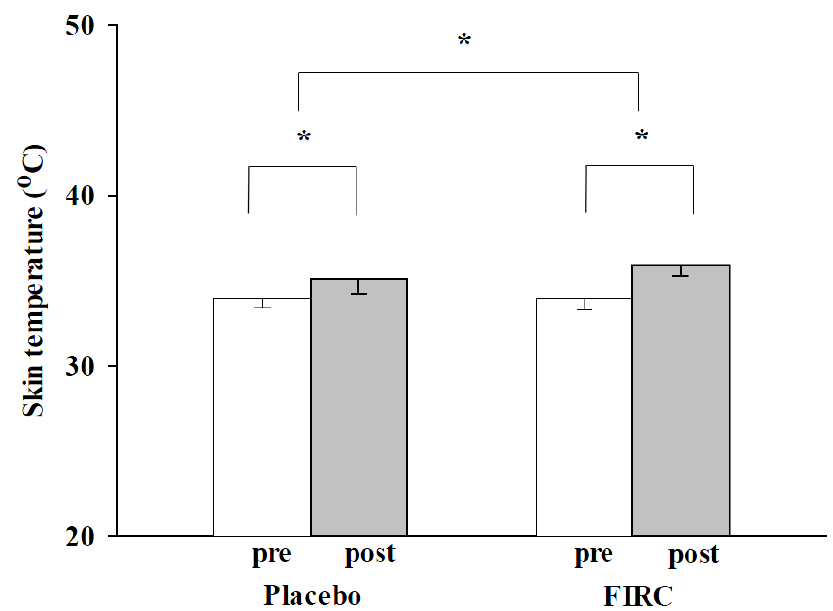
Figure 2. Changes in neck skin temperature of placebo and FIRC groups before and after intervention. Asterisk indicates a significant difference.